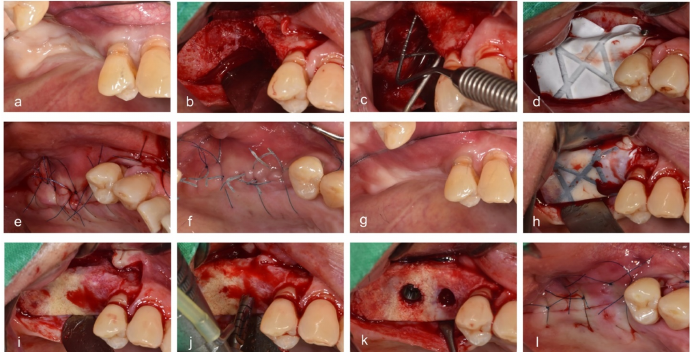
Figure 2. Surgical procedures. ( a ) Before vertical ridge augmentation, ( b ) flap reflection for augmen- tation, ( c ) measuring the defect, ( d ) grafting bone material and membrane, ( e ) suturing, ( f ) healing state when visiting for removal of stitches, ( g ) before reentry, ( h ) flap reflection for implant placement,